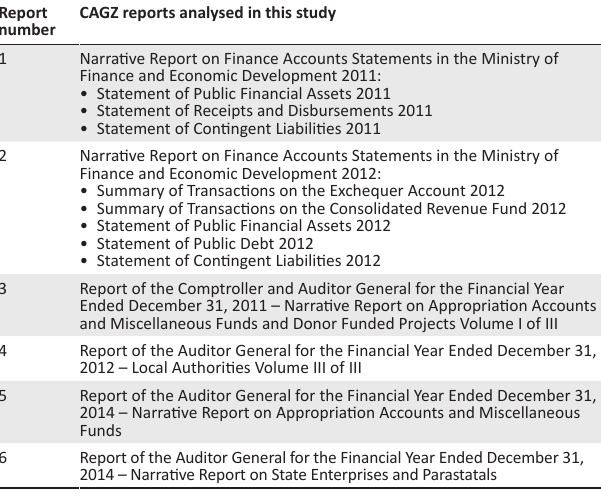
TABLE 2: The Comptroller and Auditor General of Zimbabwe (CAGZ) reports analysed in this